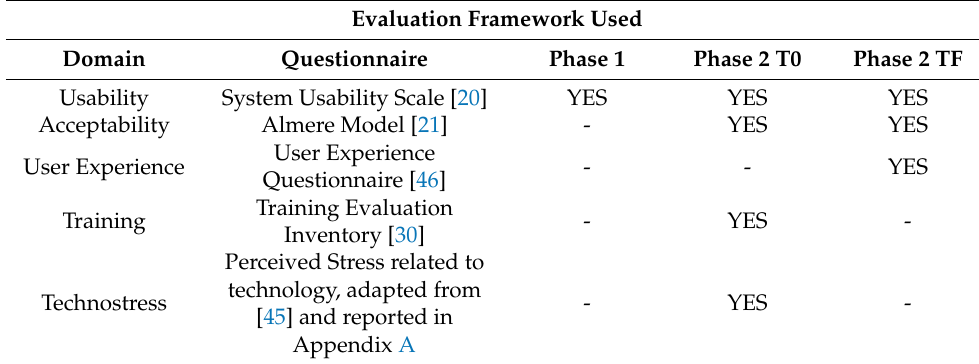
Table 4. Evaluation framework used in the two phases of the pre-validation. T0 and TF indicate the beginning and the end of Phase 2, respectively. Evaluation Framework